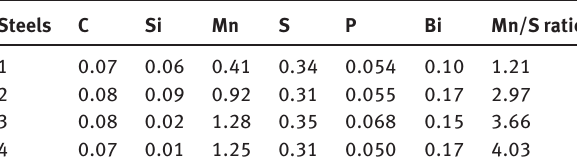
Table 1: Chemical compositions of tested steels, mass%